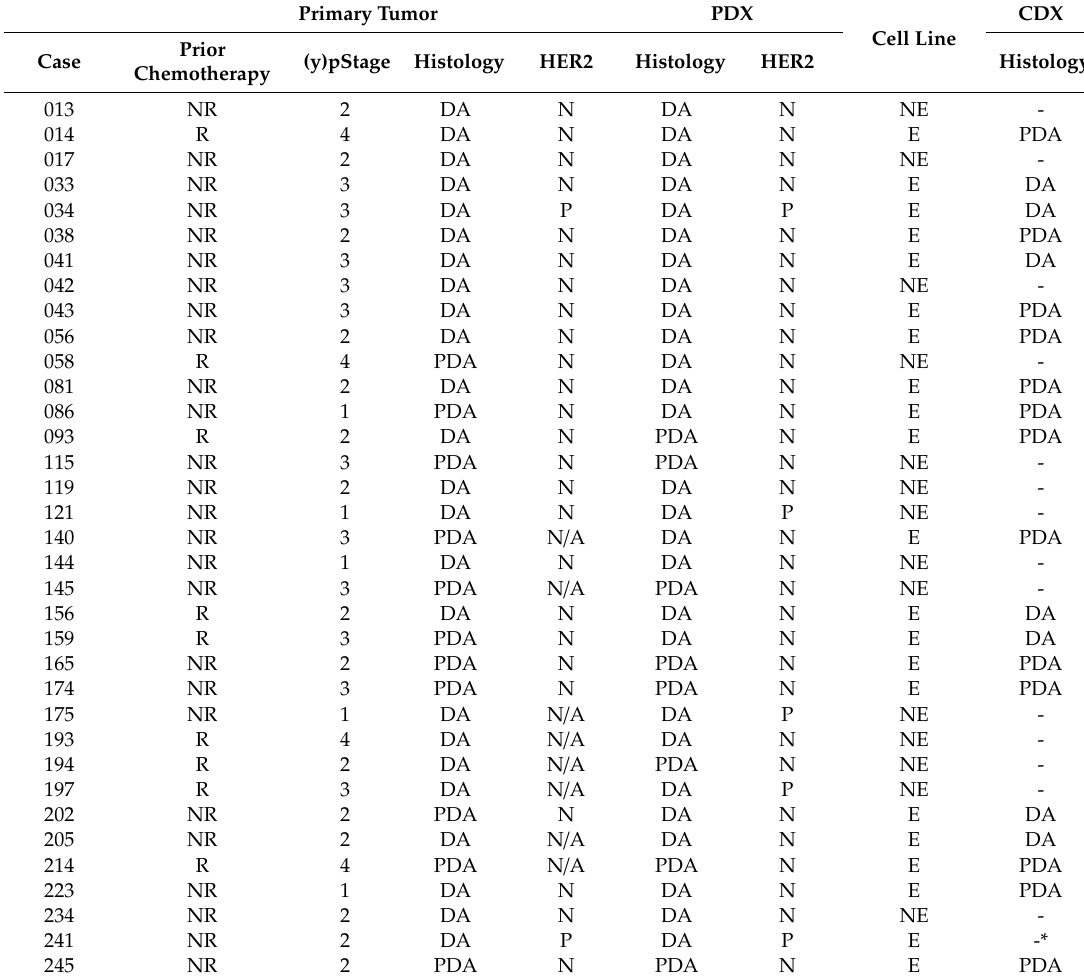
Table 8. Summary of clinicopathological characteristics of primary, PDX, and CDX